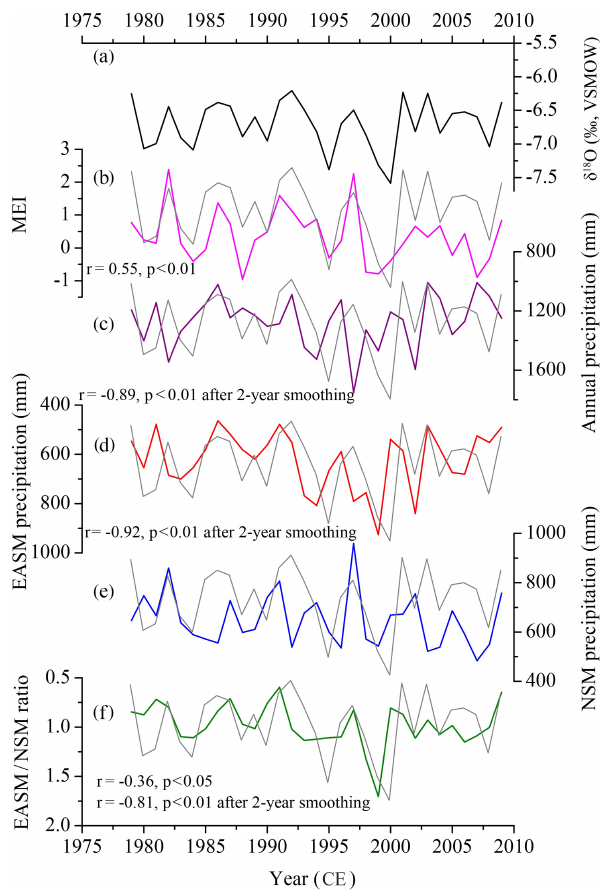
Figure 6. Correlation between the time series of the simulated δ 18 O w ( a , black line, from May to next April); MEI ( b , pink line, from October to next June); annual ( c , purple line, from May to next April), EASM ( d , red line, from May to September), and NSM ( e , blue line, from October to next April) precipitation amounts; and the EASM / NSM ratio ( f , green line) in the SPR region for 1979–2009. The correlation coefficient between δ 18 O w with MEI and EASM / NSM ratio is 0.55 ( p <0.01) and − 0 . 36 ( p <0.05), re- spectively. Applying a 2-year smoothing to δ 18 O w is significantly correlated with annual precipitation ( r = − 0 . 89, p <0.01), EASM precipitation ( r = − 0 . 92, p <0.01), and the EASM / NSM ratio ( − 0 . 81, p